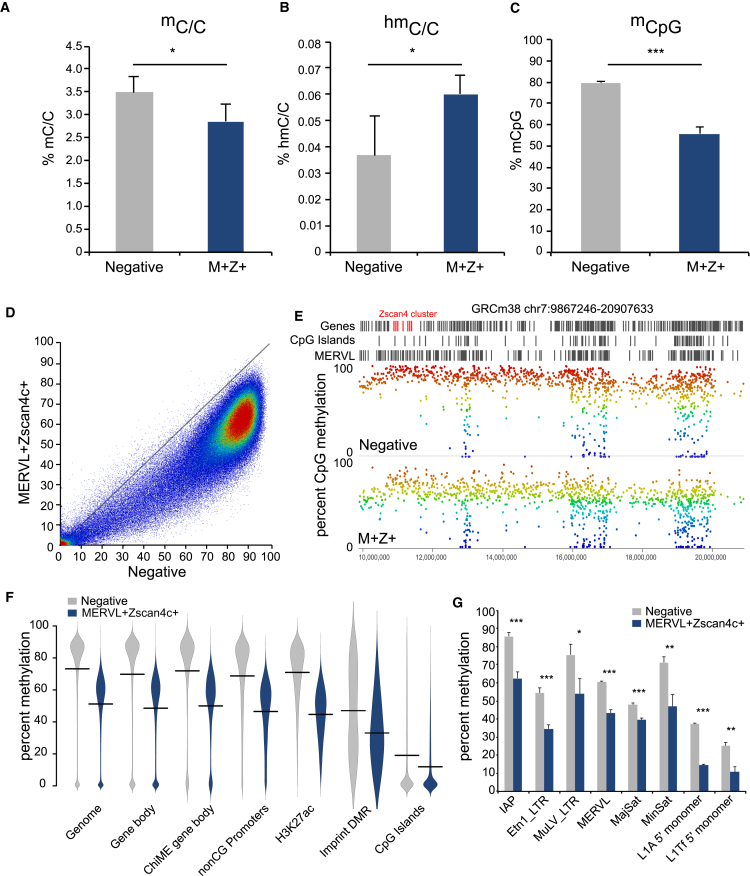
MERVL+Zscan4+ Cells Undergo Global DNA Demethylation(A and B) Total levels of (A) 5-methylcytosine and (B) 5-hydroxymethylcytosine as a percentage of total cytosine in negative-sorted (gray) and MERVL+Zscan4c+ (M+Z+, blue) cells as determined by mass spectrometry. Bars represent mean + SD of three biological replicates. ∗5mC p value = 0.015, ∗5hmC p value = 0.034, two-tailed paired t test.(C) Percentage of total CpG methylation determined by whole-genome bisulfite sequencing in negative-sorted (gray) and MERVL+Zscan4c+ (M+Z+, blue) cells. Bars represent mean + SD of three biological replicates. Difference is statistically significant (∗∗∗p = 0.000188, homoscedastic two-tailed t test).(D) Scatterplot comparing percentage of methylated cytosines between negative-sorted (x axis) and MERVL+Zscan4c+ (y axis) cells. Methylated cytosines were counted for each rolling 50-CpG window genome-wide and are expressed as percent of total cytosines per window. R = 0.469.(E) CpG methylation across part of chromosome 7 for negative-sorted (top track) and MERVL+Zscan4c+ (M+Z+) cells (bottom track). CpG methylation was quantified for each 50-CpG window and is shown as percentage of total CpGs per window. Color scale ranges from 0% methylated (blue) to 100% methylated (red). Top annotation track shows location of genes (gray) with the Zscan4 cluster highlighted in red; the middle annotation track shows location of CpG islands and bottom annotation track position of annotated MERVL elements.(F) Bean plots showing distribution of methylation levels for different genome features between negative-sorted (gray) and MERVL+Zscan4c+ (blue) cells. Lines represent mean values.(G) Methylation levels of different repeat classes between negative-sorted (gray) and MERVL+Zscan4c+ (blue) cells. Bars represent means + SD of three biological replicates.See also Figure S3.